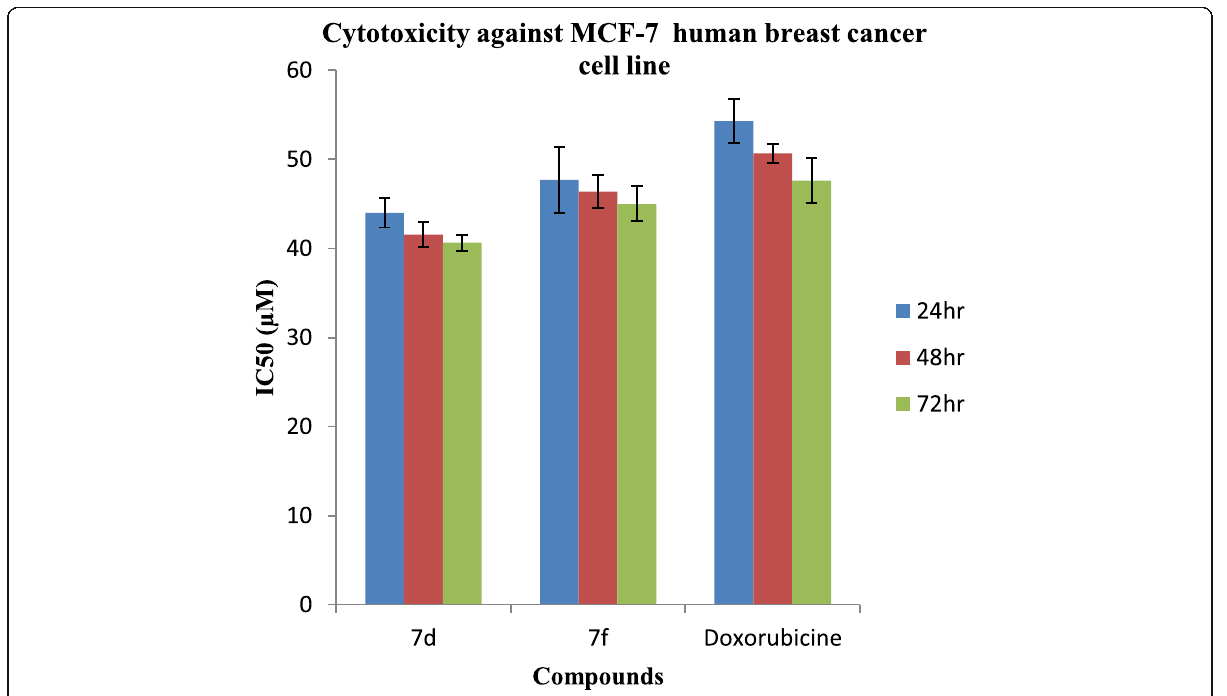
Fig. 4 Cytotoxic potential of new quinazolines in human breast cancer cell